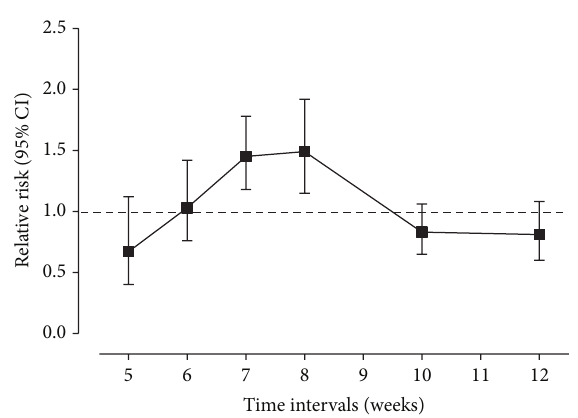
Figure 6: The relationship between time intervals and RR of pCR rates. The center of each black square is placed at the summary point estimate, and each vertical line shows the 95% confidence interval about the summary